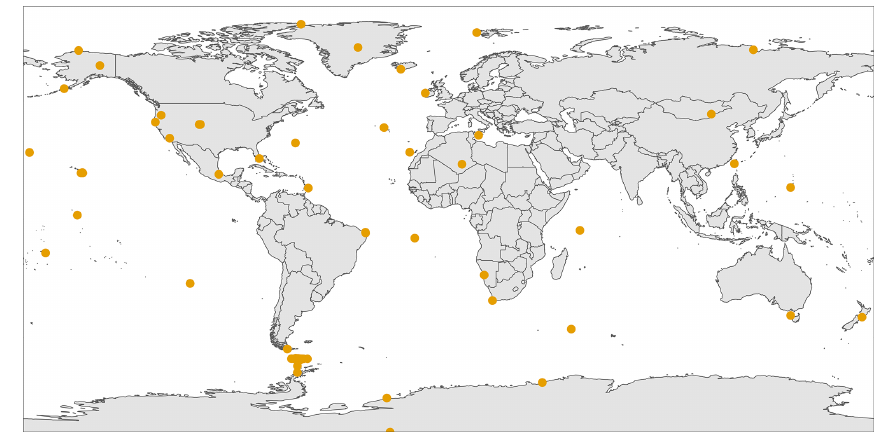
Figure 2. The locations of the observations used in this